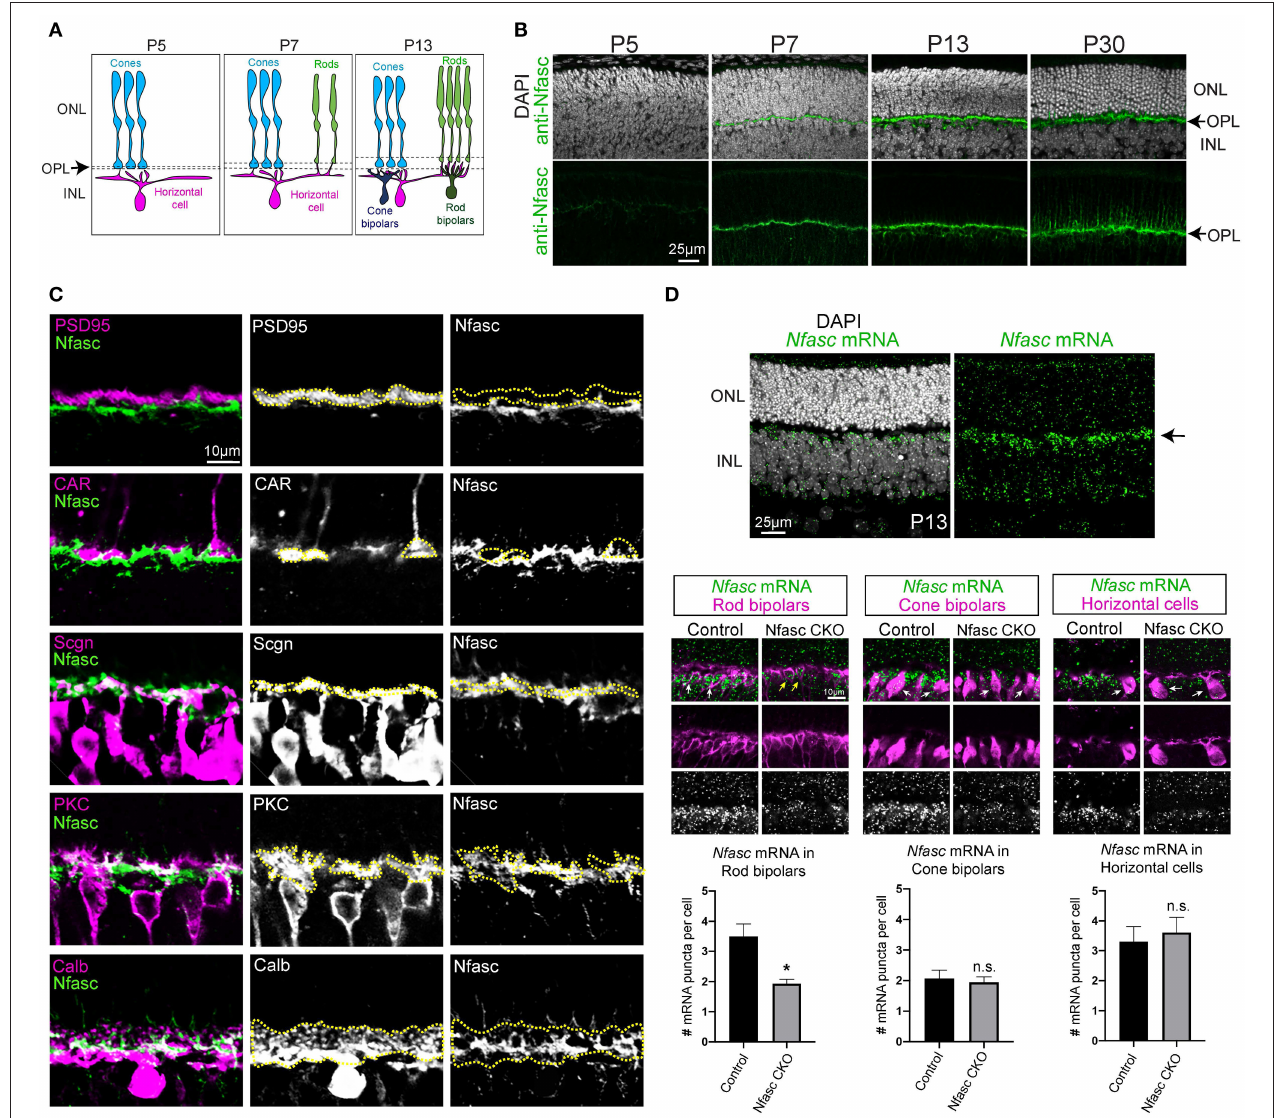
FIGURE 1 | Nfasc is expressed in the OPL during synapse formation (A–D) . Schematic drawing of outer retinal development. Cones (blue) initially make contact to horizontal cells (magenta). At P7, rods begin to contact horizontal cells. By P13, cone bipolars (dark blue) and rod bipolars (dark green) located in the inner nuclear layer (INL) form synapses with cones and rods, respectively (A) . Antibody staining in wild-type retinas reveals Nfasc (green) is not detected at P5 and only becomes visible until P7 when the OPL emerges. Nuclei is stained with DAPI (B) . Co-labeling of Nfasc with known cell-type specific markers (C) . Rod terminals are stained with anti-PSD-95 (magenta) and show little overlap with anti-Nfasc (green) as depicted with yellow dotted traces. Cone terminals (anti-CAR, magenta) also shows little co-localization with Nfasc (green). Nfasc appears to be expressed in the same layer as the dendrites of cone bipolars (anti-Scgn) and rod bipolars (anti-PKC) as well as with the processes of horizontal cells (anti-Calb) (C) . Nfasc mRNA (green) is detected by in situ hybridization in wild-type retinas at P13 and shown to localize to the top-most region of the INL. Antibody staining after in situ hybridization shows Nfasc mRNA expression in rod bipolars (anti-PKC), cone bipolars (anti-Scgn), and horizontal cells (anti-Calb). Quantification of Nfasc mRNA puncta (0.6 µ m in size) per cell shows Nfasc is significantly reduced in rod bipolars but not in cone bipolars nor horizontal cells in Nfasc CKO. Data are represented as mean values ± SEM. Statistical significance determined by an unpaired two-tailed Student’s t -test. * p < 0.05. Images are shown as confocal sections. Scale bar shown in each figure